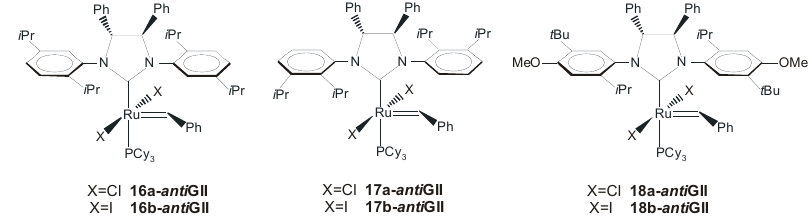
Figure 13. Catalysts 16-GII – 18-GII bearing monodentate NHCs with anti backbone.